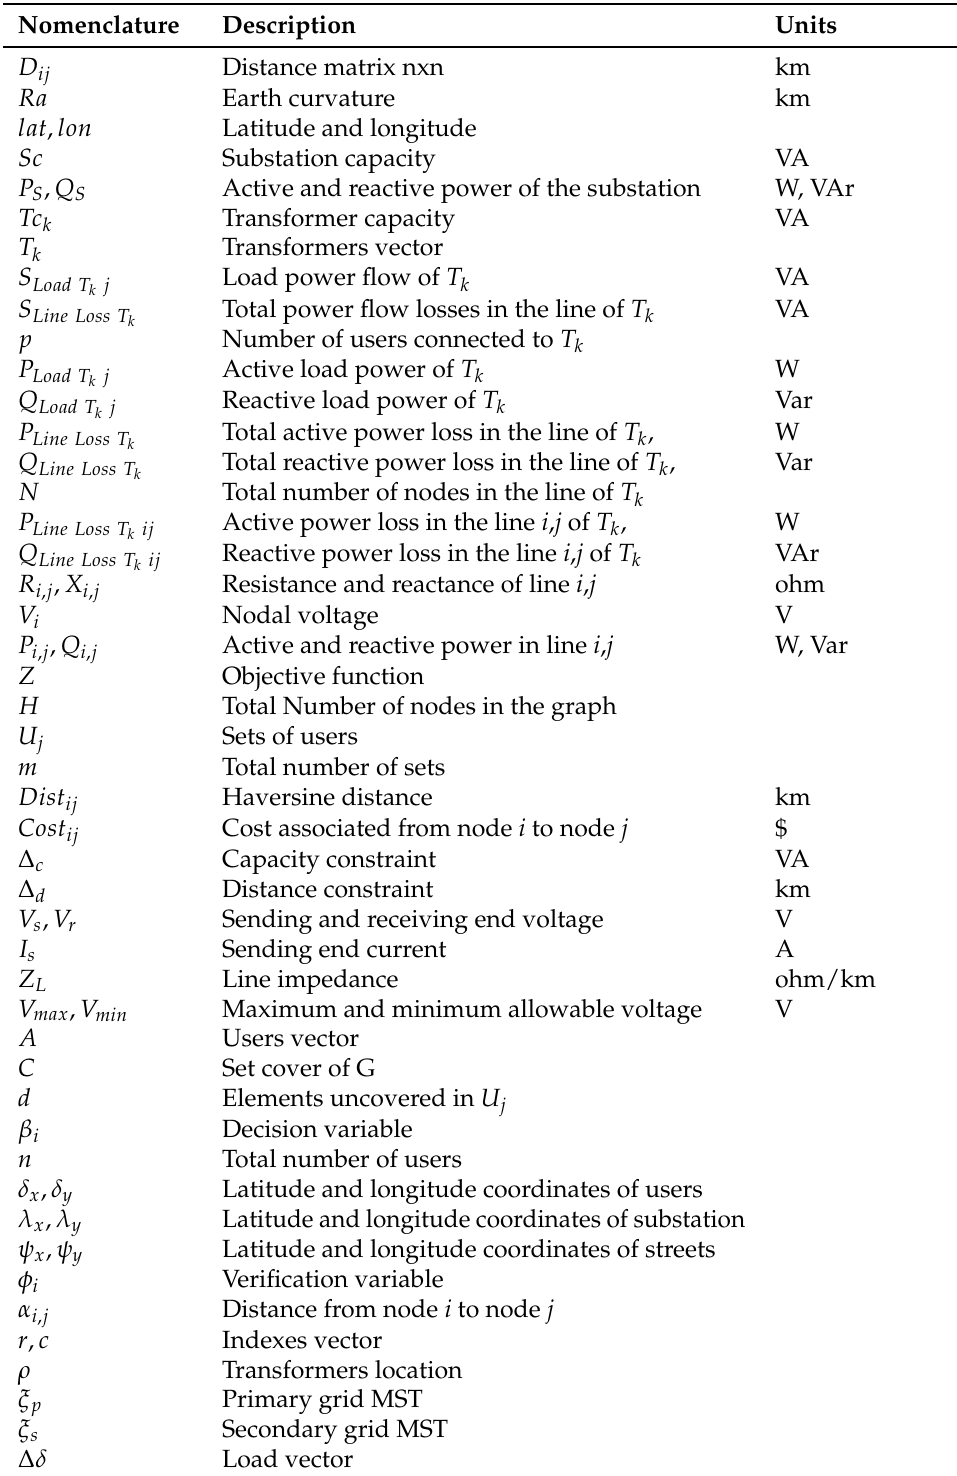
Table 2. Notation used in this